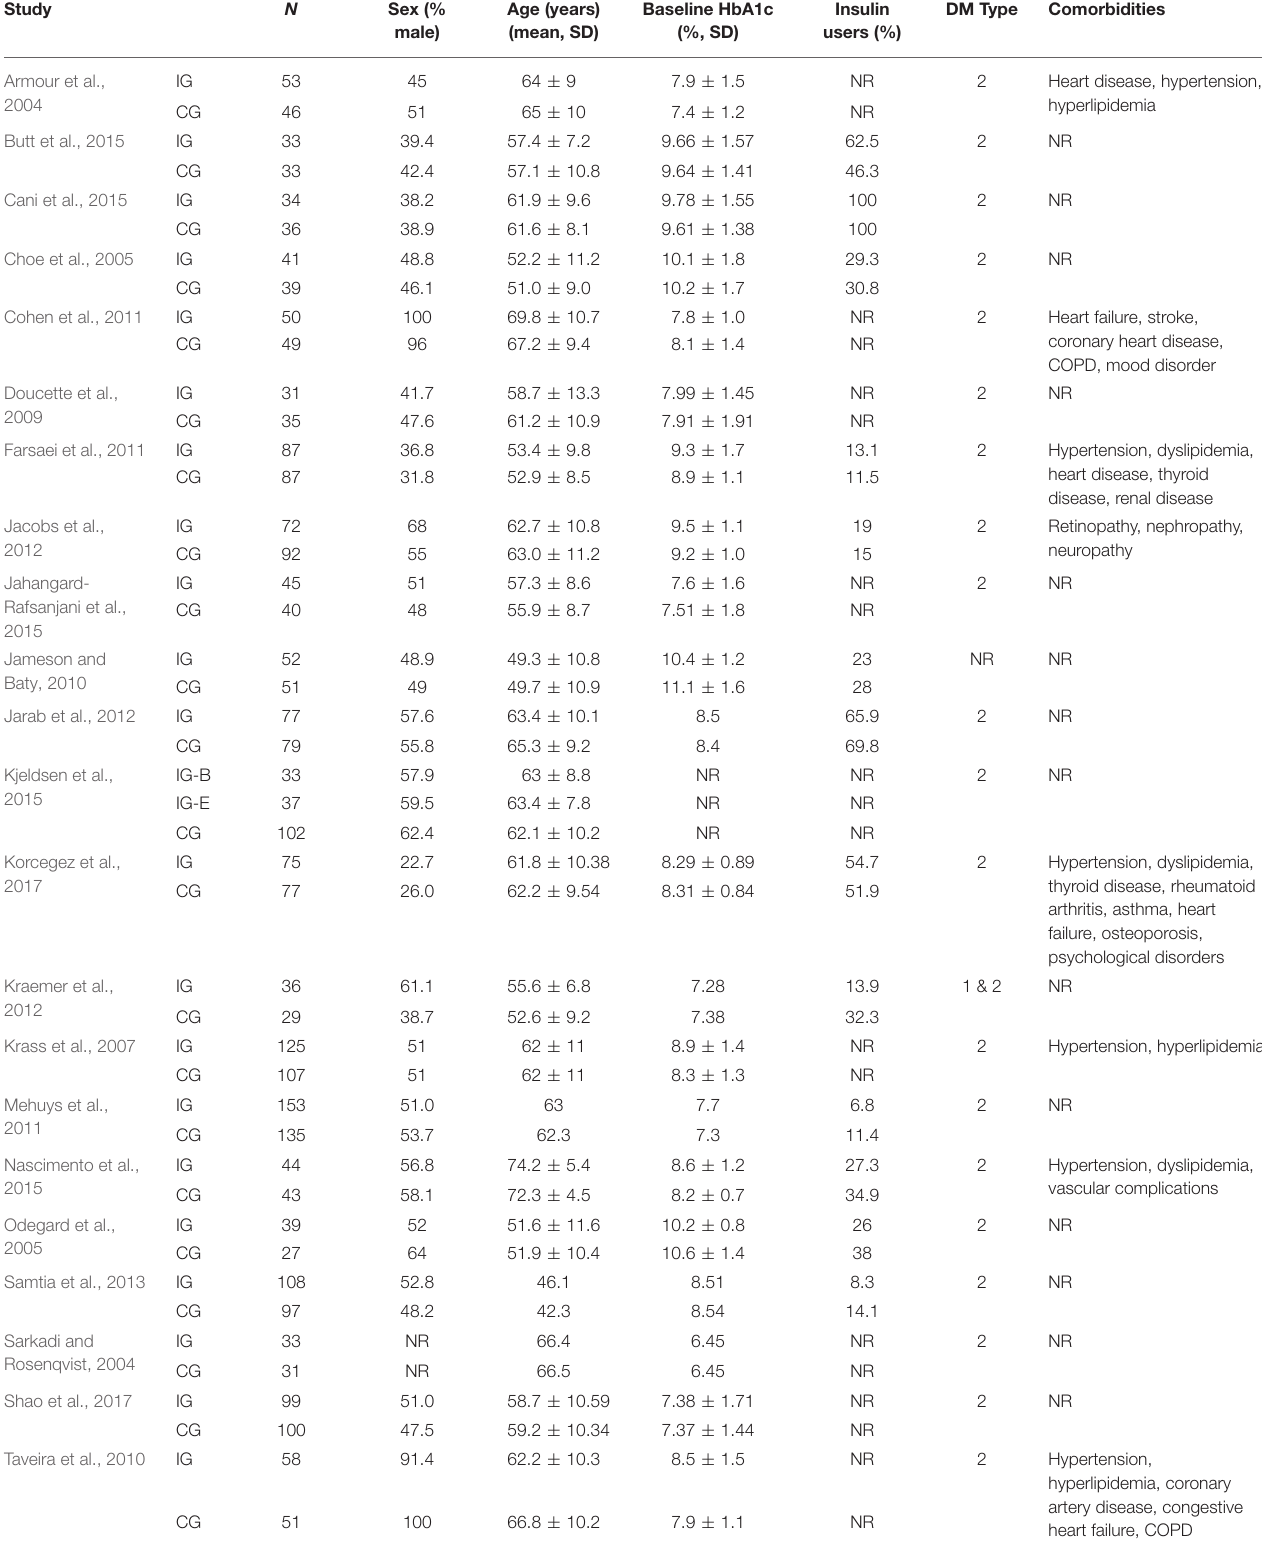
TABLE 2 | Main characteristics of the study